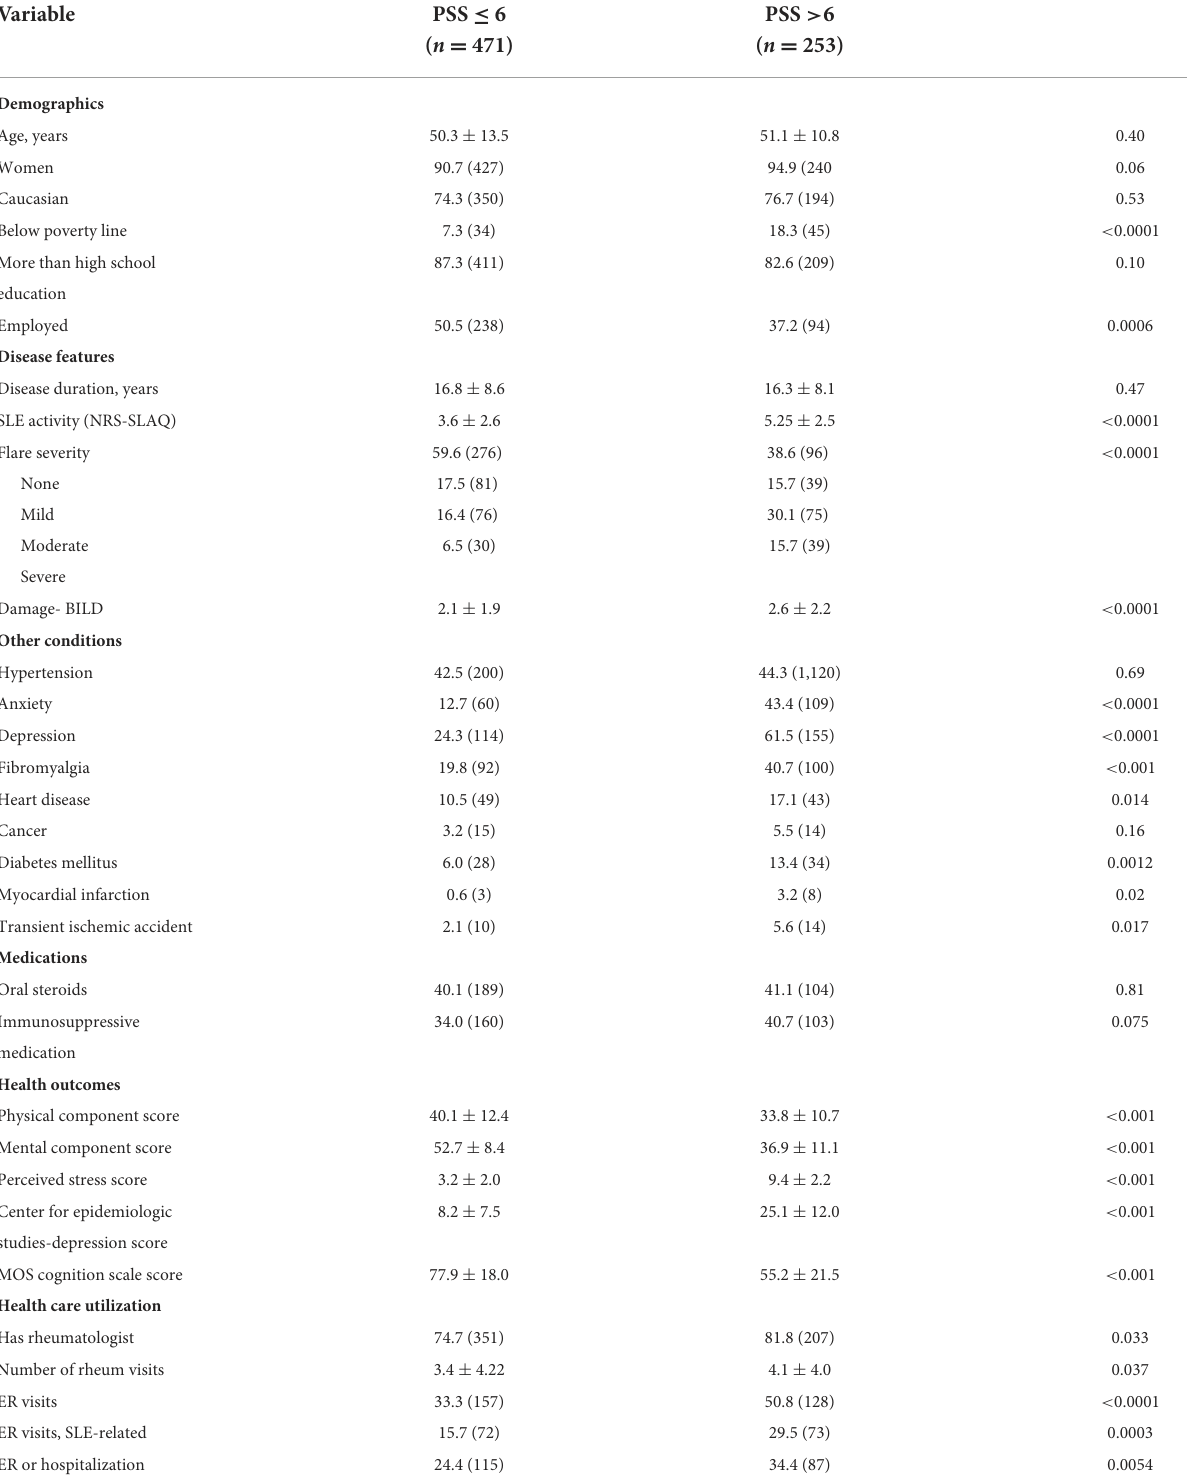
TABLE 2 Comparison by level of stress.